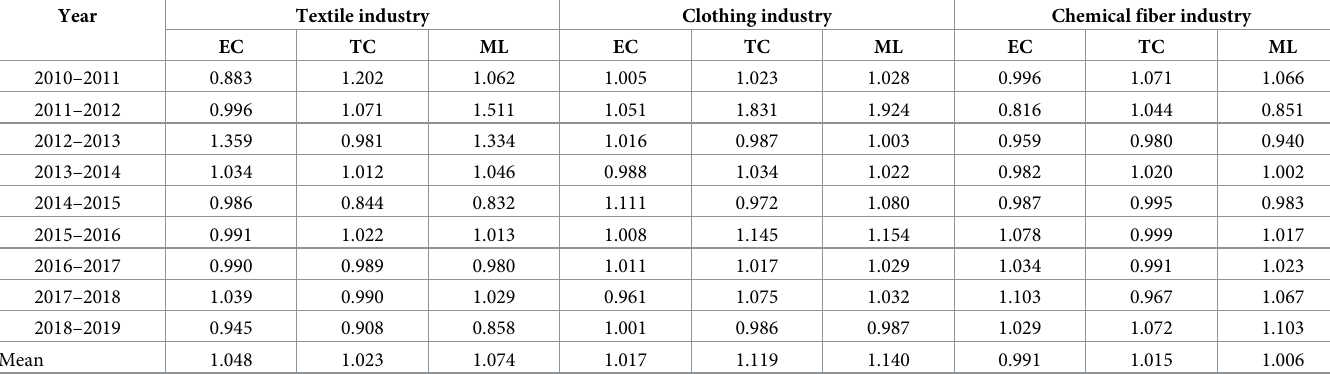
Table 6. Decomposition of ML of GTFP in textile and apparel industry during